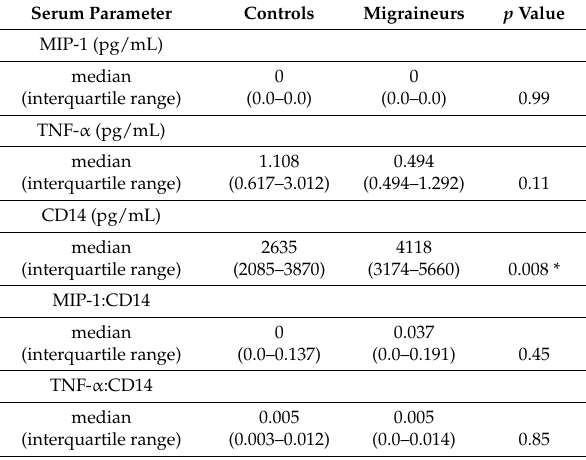
Table 3. Serum MIP-1, TNF- α , CD14 and MIP-1:CD14 and TNF- α :CD14 in monocyte fraction in migraine patients and